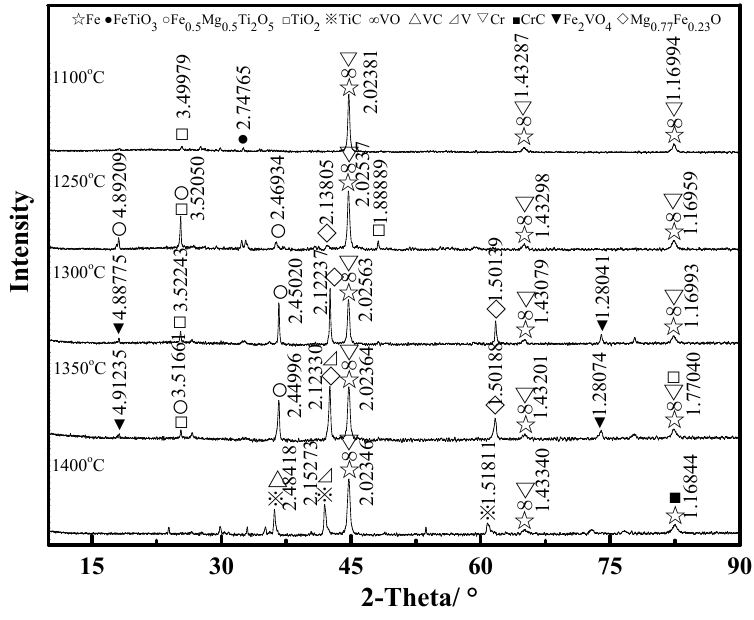
Figure 4. XRD patterns of the reduced LGVTMP at different temperatures.